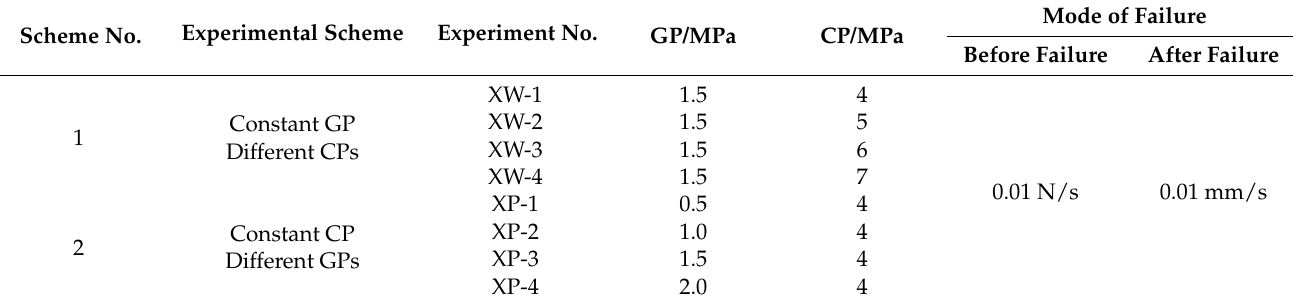
Table 3. Scheme for unloading